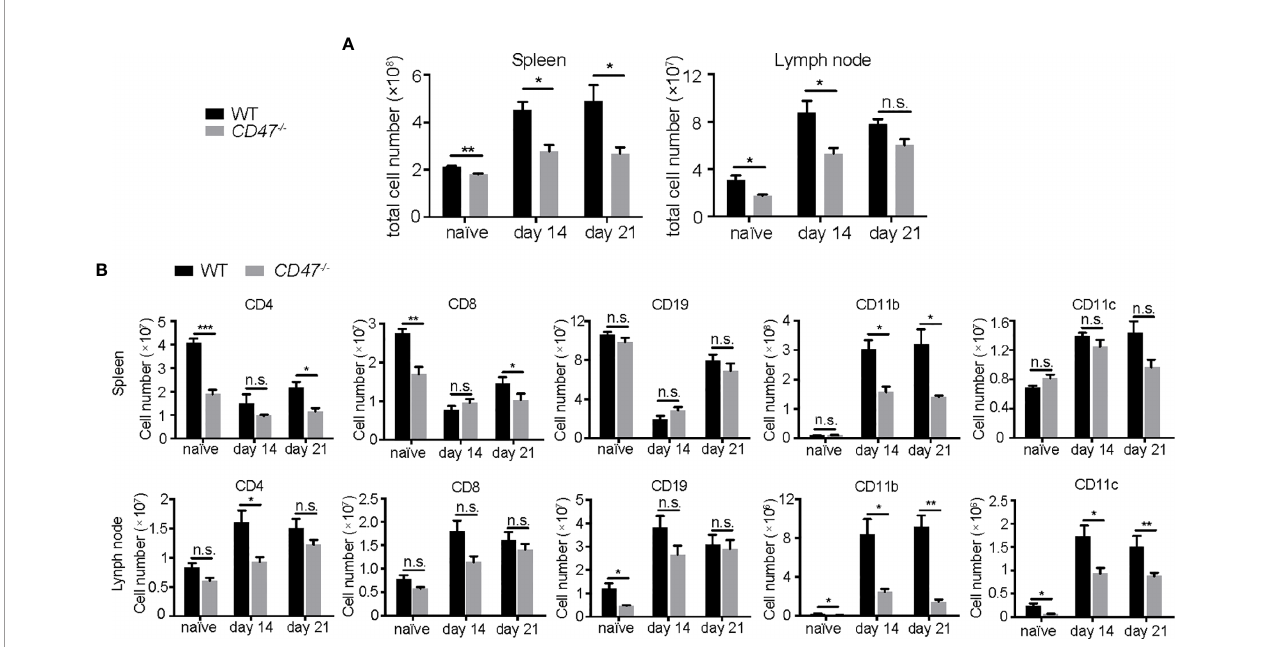
FIGURE 4 | The number of T cells, macrophages, and DCs are decreased in CD47 de fi cient mice with autoimmune uveitis. Spleen and lymph node cells from WT and CD47 -/- mice were collected before (naive), and 14 days and 21 days post immunization. (A) Total cell number in spleens and lymph nodes. (B) CD4 + , CD8 + , CD19 + , CD11b + , CD11c + cells in spleens and lymph nodes were detected by fl owcytometry and cell number of each population was calculated. The cells were gated on live CD45 + CD3 + cells to detect CD4 + T cells and CD8 + T cells. CD45 + CD3 - population was further gated on CD19, CD11b, and CD11c. Data were analyzed by Student ’ s t test and expressed as mean ± SEM. *P<0.05; **P<0.01; ***P<0.001. n.s., not signi fi cant. n=4 mice per